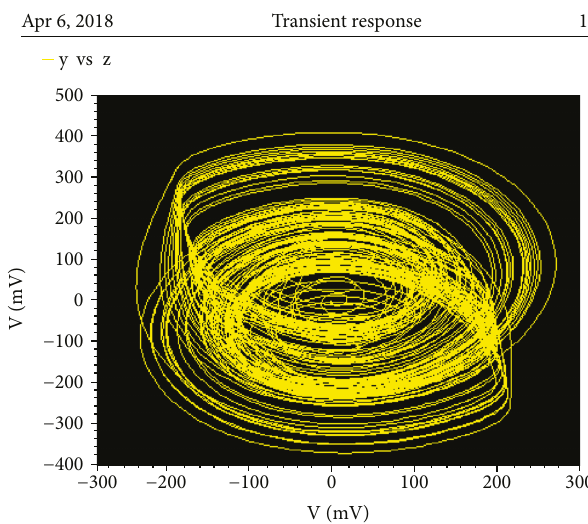
Figure 16: The phase portrait in the y - z plane (S and S are turned o ff 3